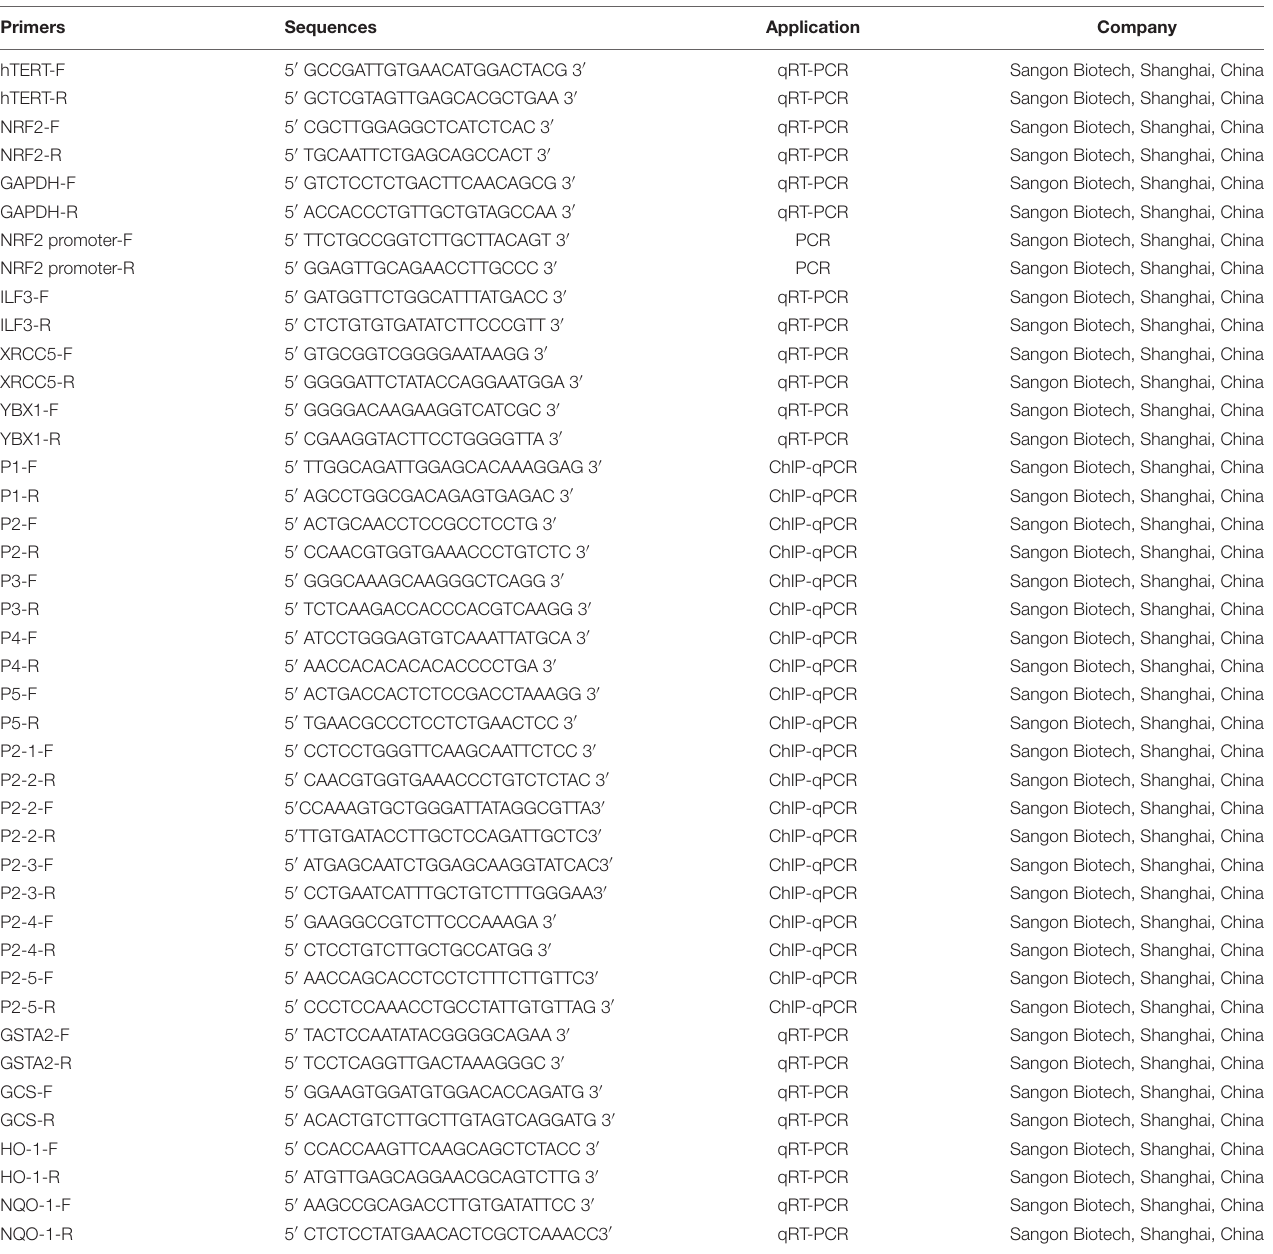
TABLE 1 | Primer sequences used in this